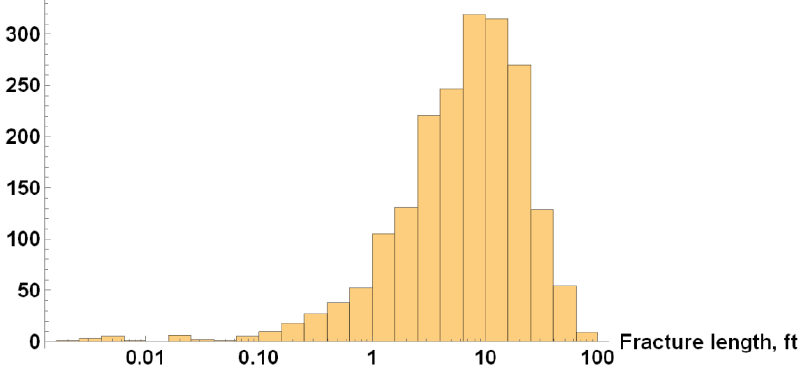
Figure 7—Histogram of the fracture length in Case